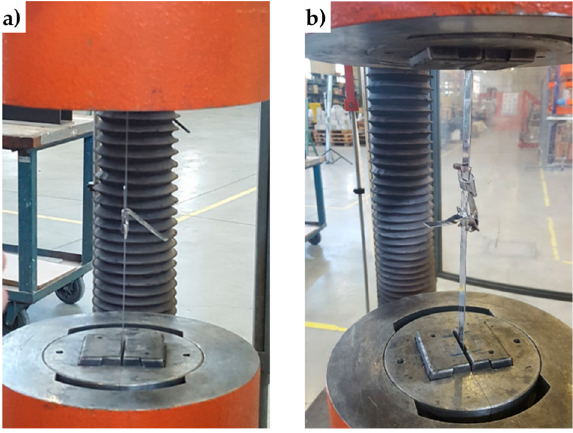
Figure 30. Junction unfastening: a ) specimen with one seal and b ) specimen with two seals.